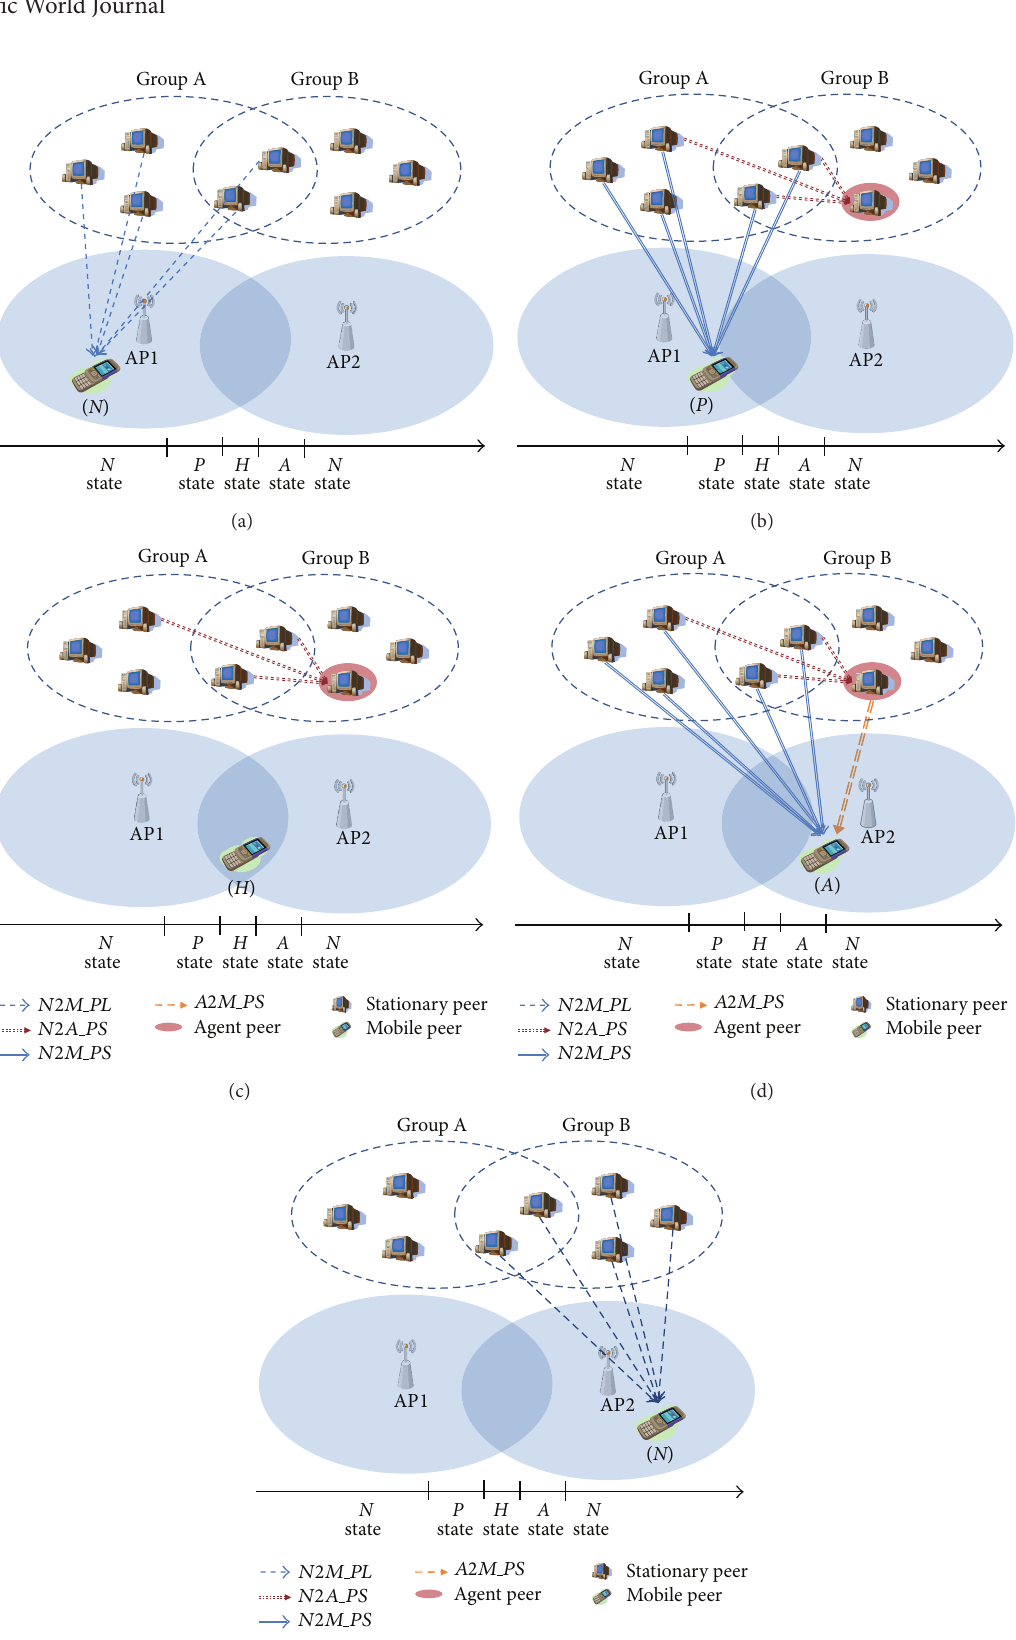
Figure 2: Data transmission route and manner according to a mobile peer’s state: (a) 𝑁 state before handover, (b) 𝑃 state, (c) 𝐻 state, (d) 𝐴 state, and (e) 𝑁 state after